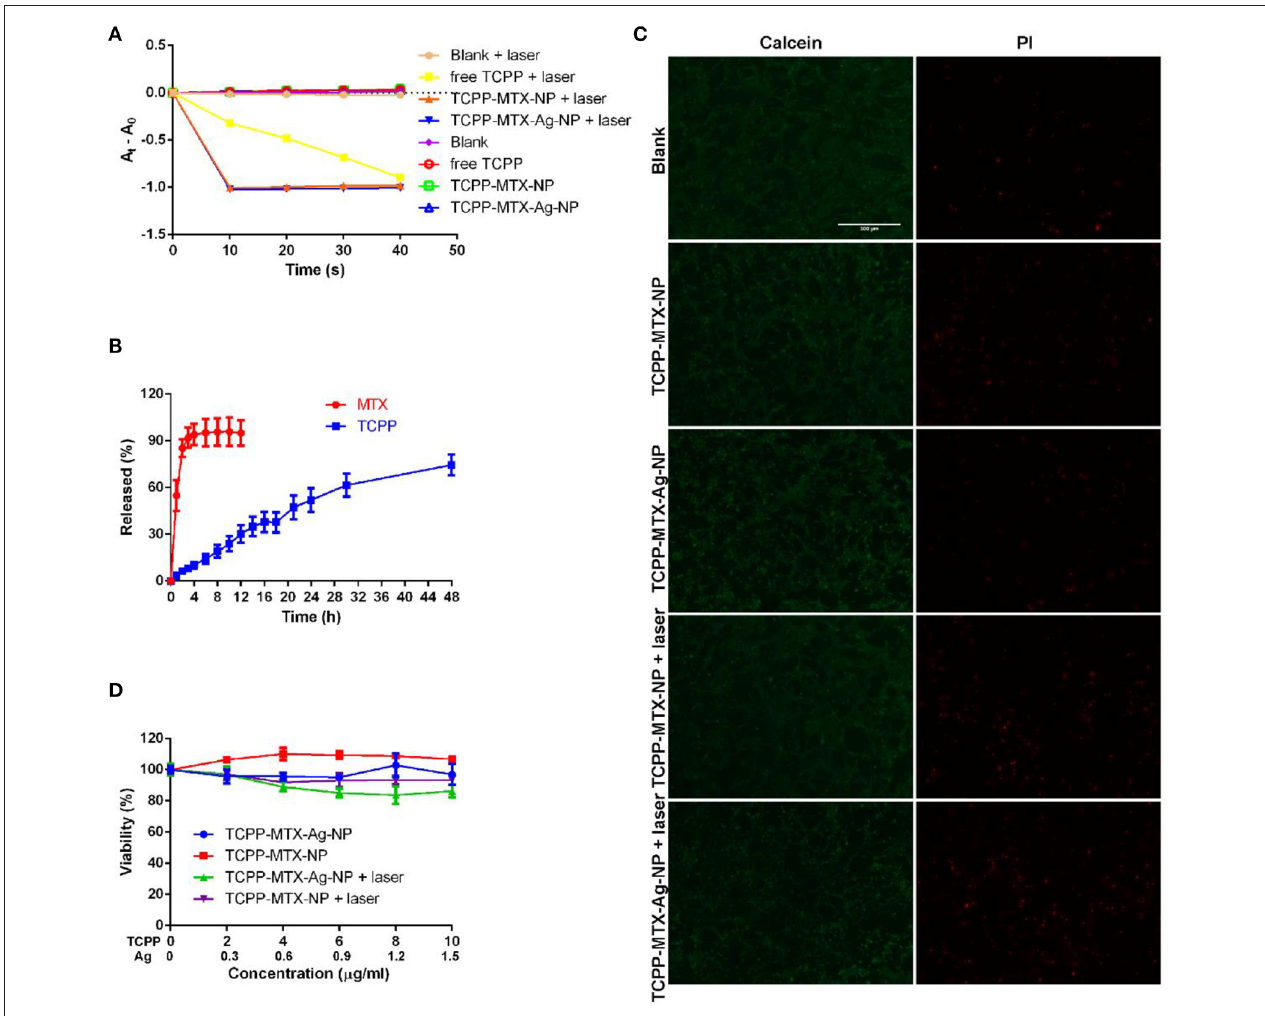
FIGURE 3 | The ROS generation, drug release and biocompatibility of the supermolecular nano-carriers. (A) The ROS generation measured by the DPBF method; (B) The release of TCPP and MTX from the TCPP-MTX-Ag-NP; (C) The biocompatibility assessment by the Calcein/PI experiment (the scale bar represents 300 µ m) in L02 cells; (D) The biocompatibility evaluation by the MTT method in L02 cells.